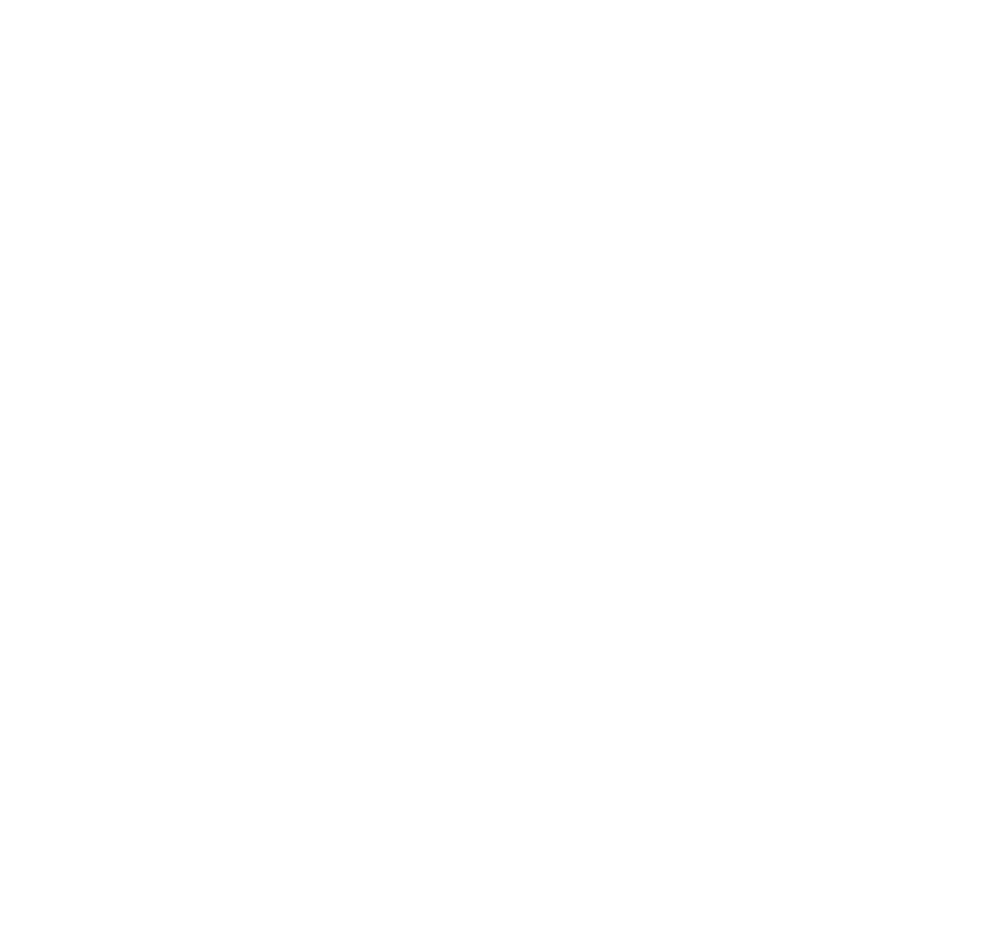
Fig. 5 (previous page). Scoliidae Latreille, 1802, measurements and morphological terms. For measurements refer to definitions in Material and methods section, body morphological terms follow Gupta & Jonathan (2003) and the wing terminology follows Goulet & Huber (1993). A . Scolia clypeata pseudovollenhoveni Betrem, 1933, ♀, dorsal view of head, mesosoma, T1 and T2. B . Sc. pakshaoensis sp. nov., paratype, ♂ (CBC), lateral view of head and mesosoma. C . Liacos erythrosoma (Burmeister, 1854), ♀, face fontal view. D . L. erythrosoma , ♀, vertex dorsal view. E . Fore wing cells and venation of Megacampsomeris prismatica (Smith, 1855), ♂. F . Fore wing of L. erythrosoma , ♂. Abbreviations: An. Oc. = Anterior ocellus; Cly. = Clypeus; Cr. fu. = Cross-furrow of mesopleuron; Cr. fu. = Frontal cross-furrow; dl. Ar.Prop. = dorso-lateral area of Propodeum; dm.Ar. Prop. = dorso-median area of Propodeum; Epi. sc. = Episternal scrobe; Fr. Ar. = Frontal area; Fr. Fis. = Frontal fissure; Fr. La. = Frontal lamina; Fr. pi. = Frontal pit; Fr. Spa. = Frontal spatium; Ho. Ar. = Horizontal area of mesopleuron; La. ca. = Lateral carina; La. su. = Lateral Surface; Lo. pl. mes. = Lower plate of mesopleuron; Lo. pl. met. = Lower plate of metapleuron; Mand. = Mandible; Mes. cr. = Mesopleural crest; Mes. sc. = Mesoscutum; Met. = Metanotum; Oc. Sin. = Ocular sinus; Par. fur. = Parapsidial furrow; Po. Oc. = Posterior ocellus; Pro. = Pronotum; Prop. Spi. = Propodeal spiracle; Sca. = Scapula; Scu. = Scutellum; T1 = Tergum 1; T2 = Tergum 2; Teg. = Tegula; Up. pl. mes. = Upper plate of mesopleuron; Up. pl. met. = Upper plate of metapleuron; Ver. = Vertex. Wing cells names: 1M = First medial (1 st discal cell); 1m-cu = 1 st recurrent vein; 1R1 = 1 st submarginal cell; 1Rs = First radial sector (2 nd submarginal); 2M = Second medial (2 nd discal); 2m-cu = 2 nd recurrent vein; 2Rs = Second radial sector (3 rd submarginal